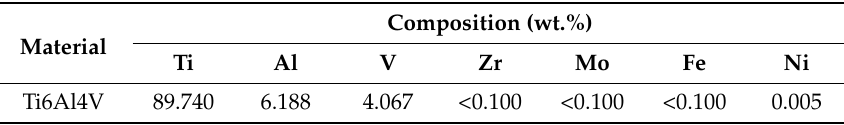
Table 1. The chemical composition of